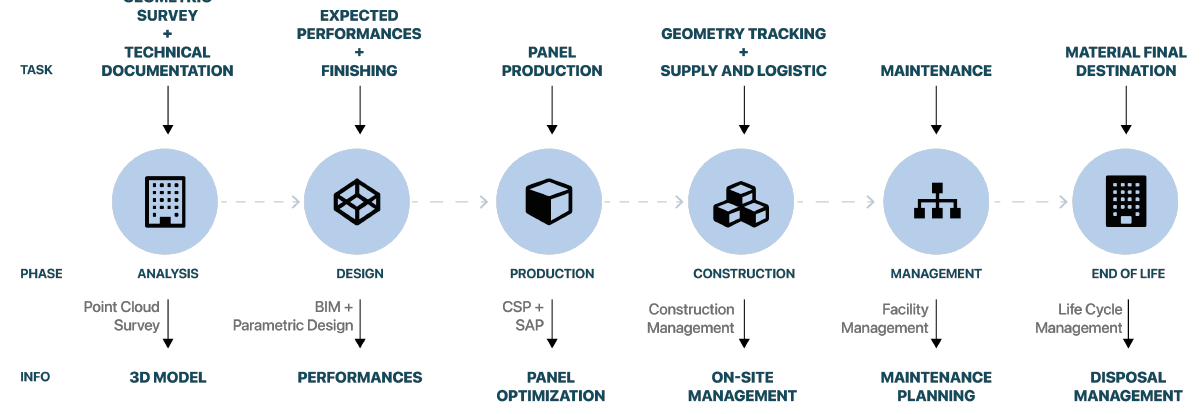
Figure 1. Information flow for panelisation